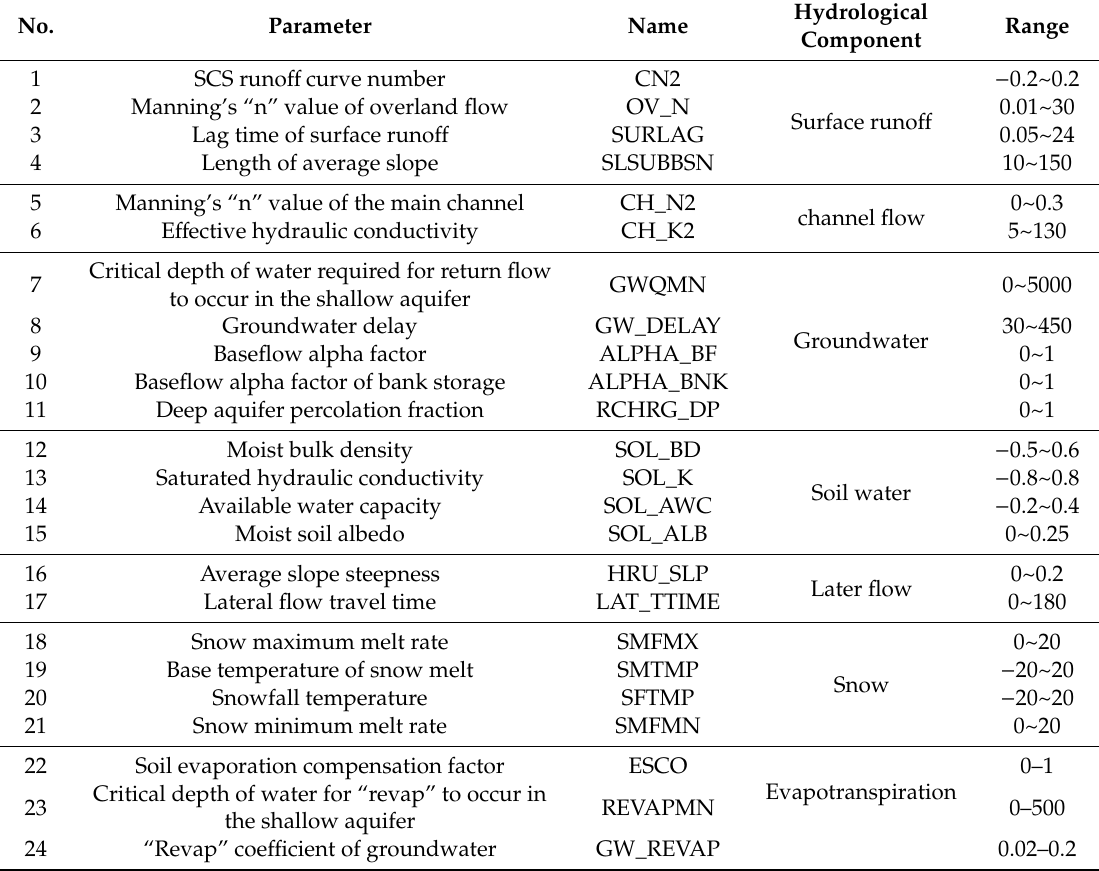
Table1. Parametersforsensitivityanalysisrelevanttodi ff